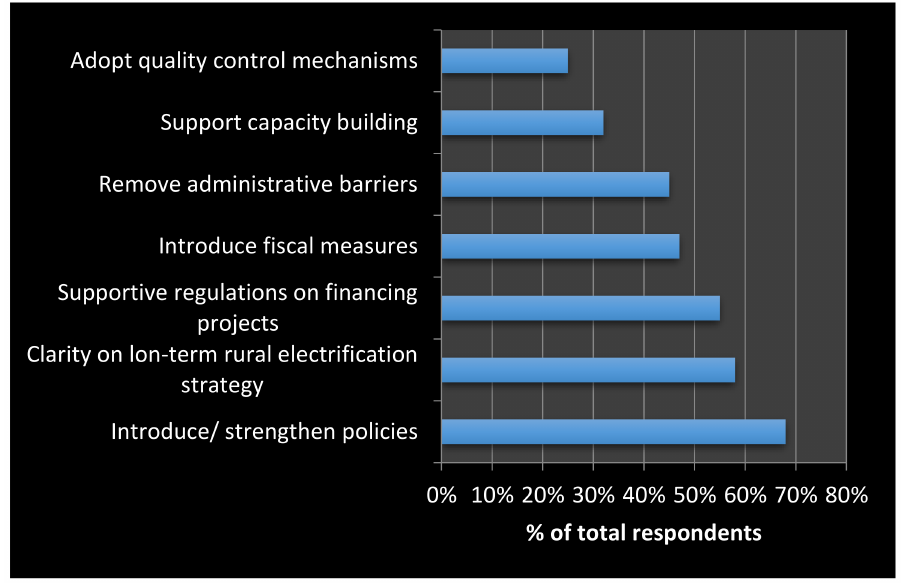
Figure 5. Areas for government intervention in off-grid sector. Source: [44].